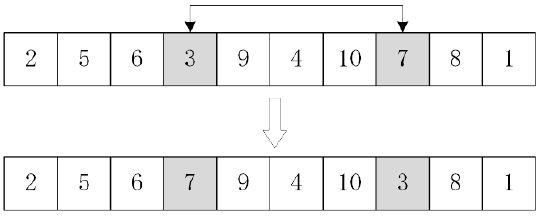
Figure 6. An instance of the mutation operation.